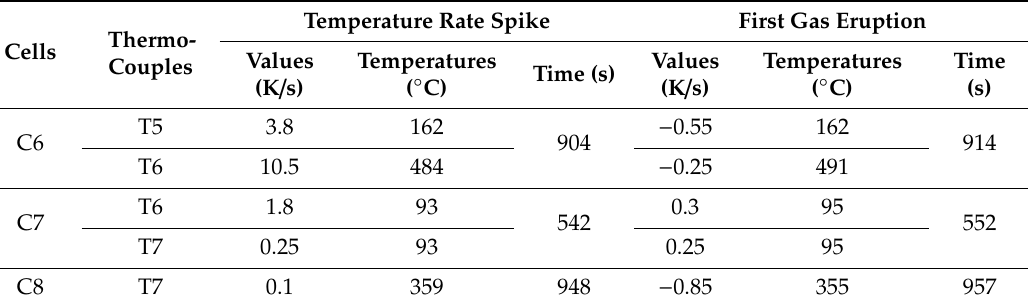
Table 6. Pole temperature rate spikes and first gas eruption.